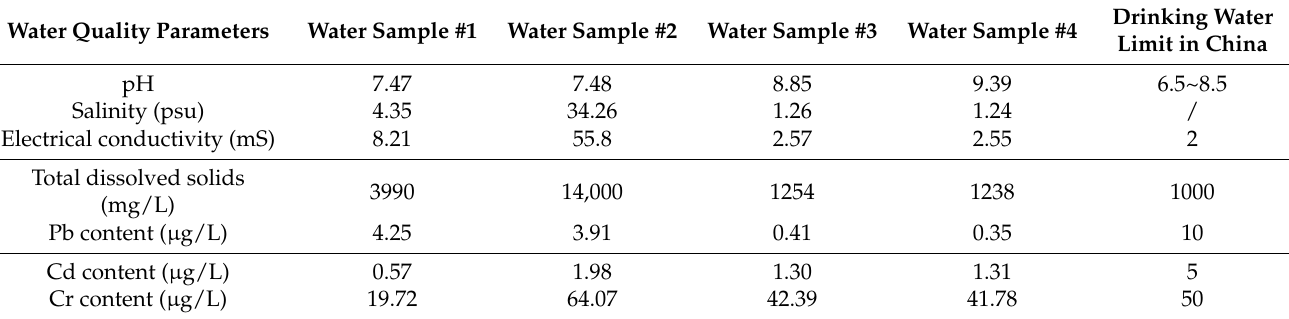
Table 5. Water quality parameters and heavy metals contents of water samples collected close to combustion byproduct